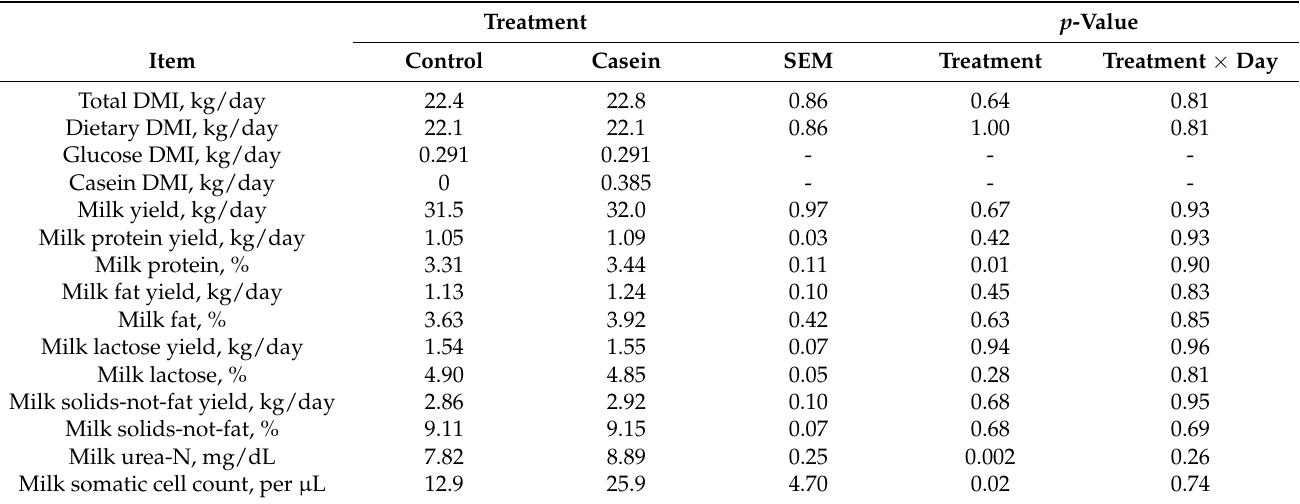
Table 3. Effect of casein supplementation on dry matter intake (DMI) and milk production and composition from days 5 through 8 of each